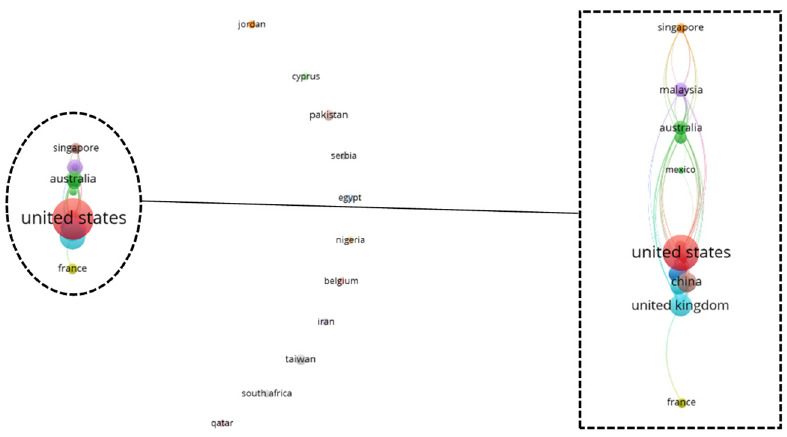
Figure 13. Bibliographic coupling network analysis: country.